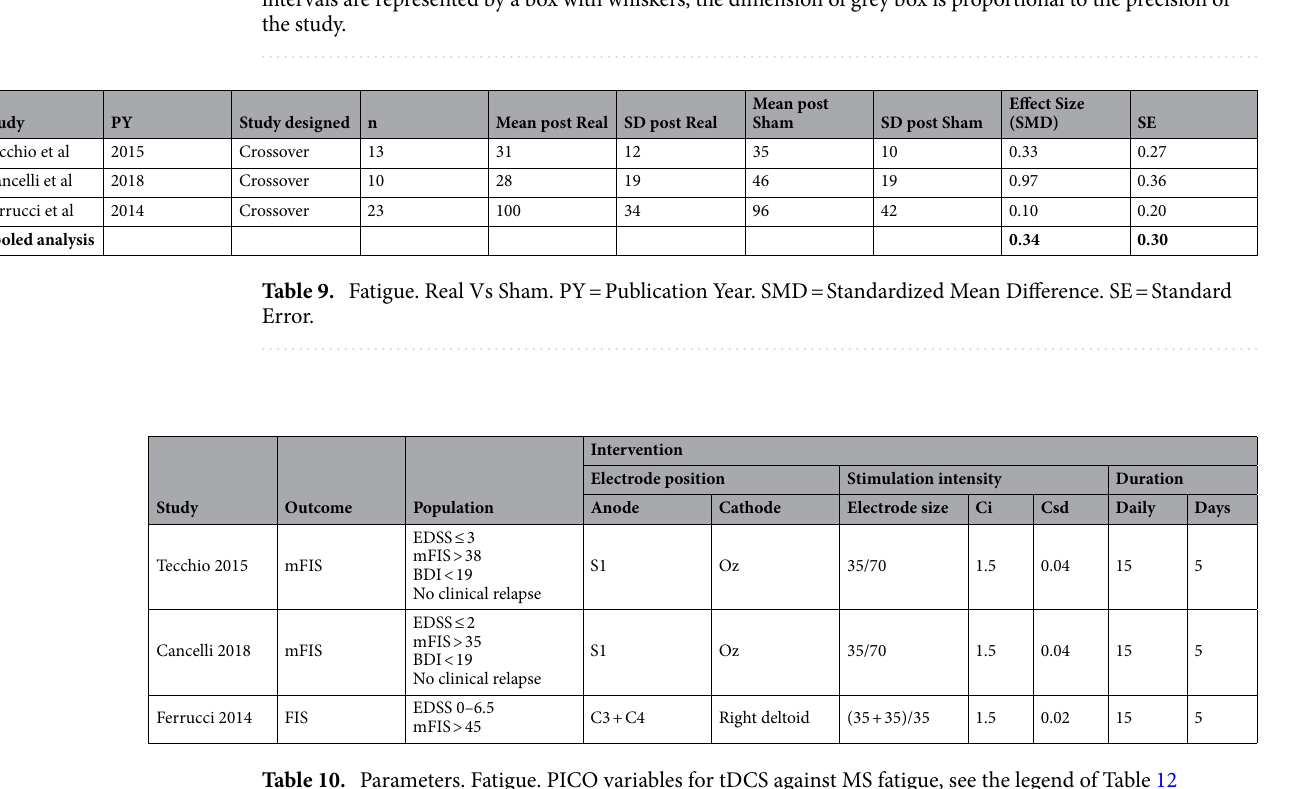
Table 10. Parameters. Fatigue. PICO variables for tDCS against MS fatigue, see the legend of Table 12